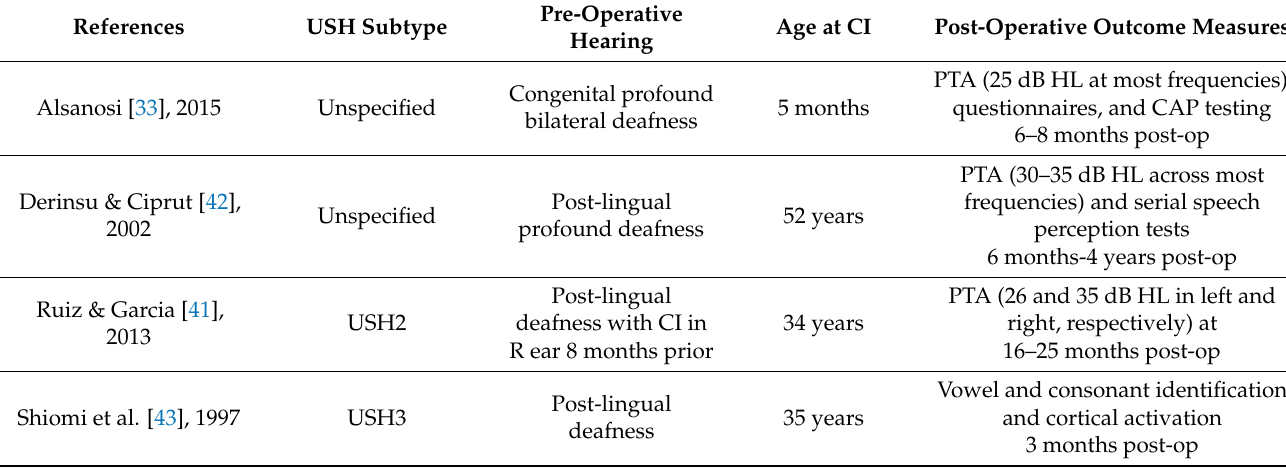
Table 4. Features of case